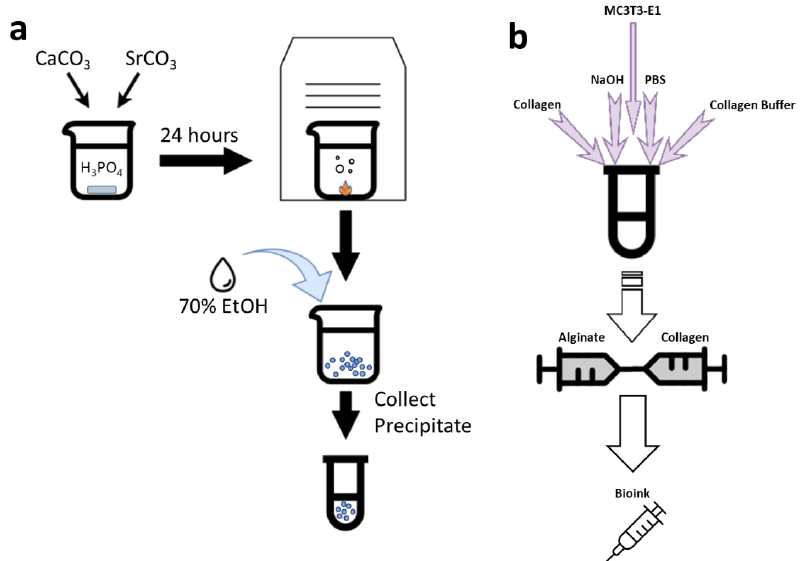
Figure 1. ( a ) Synthesis and collection of 1% Strontium Calcium Polyphosphate (SCPP). Briefly, CaCO 3 and SrCO 3 were mixed in H 3 PO 4 and heated for 24 h and washed with 100% EtOH afterwards. ( b ) Reconstitution and neutralization of type 1 collagen mixed with alginate to form the bioink. The collagen was reconstituted with slightly alkaline pH with the addition of PBS, NaOH, and collagen buffer. After collagen reconstitution, MC3T3-E1 pre-osteoblasts were added to facilitate attachment with the collagen prior to mixing with